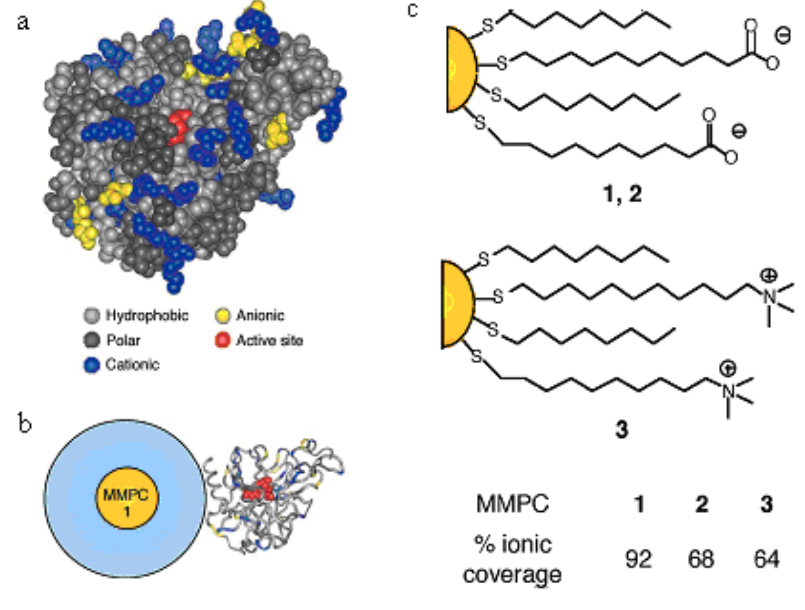
Figure 1. (a) Space-filling model of ChT. Surface binding of the proteins by anionic MMPCs focuses on the ring of cationic residues situated around the active site, functionally significant residues are noted. (b) Relative sizes of ChT and MMPC 1 . (c) Anionic MMPCs 1 and 2 and cationic control 3 (reproduced with permission from [25] © 2004, National Academy of Sciences,